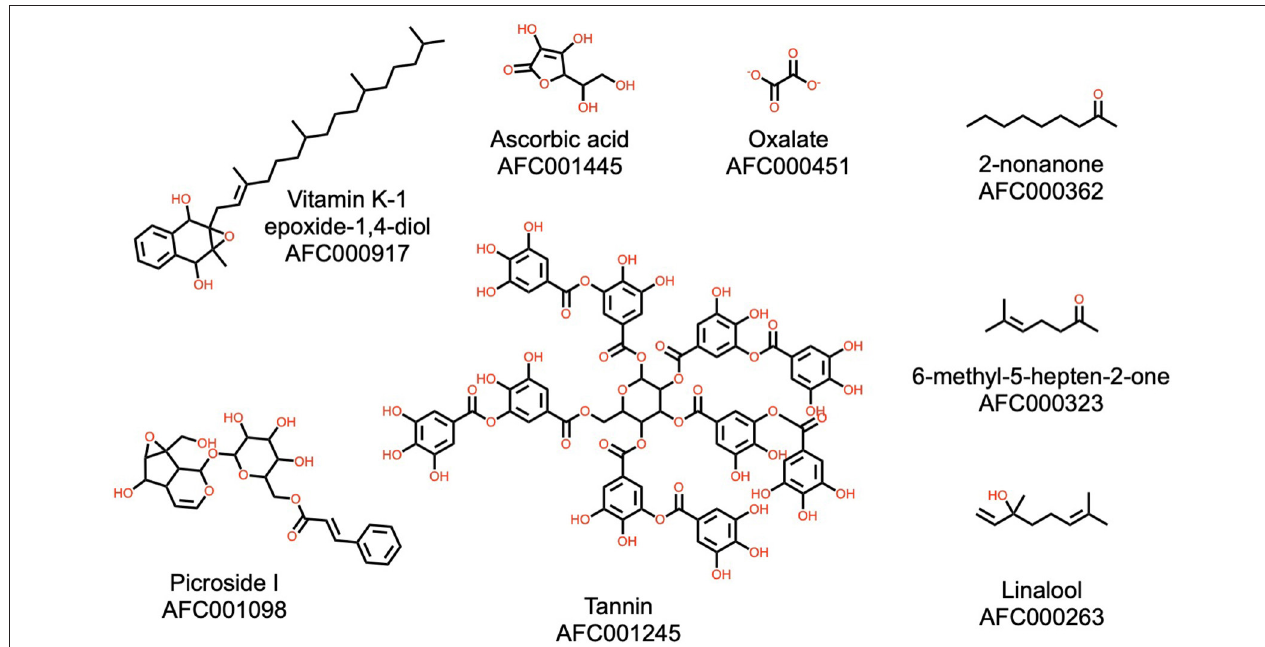
FIGURE 9 | Additional noteworthy natural products present in the watermelon plant. The illustrated structures represent compounds not placed in the classes represented in Figures 2 – 8 . These include a tannin and some volatile compounds. AFC identifiers are defined in Materials and Methods, section AFC Identifiers.